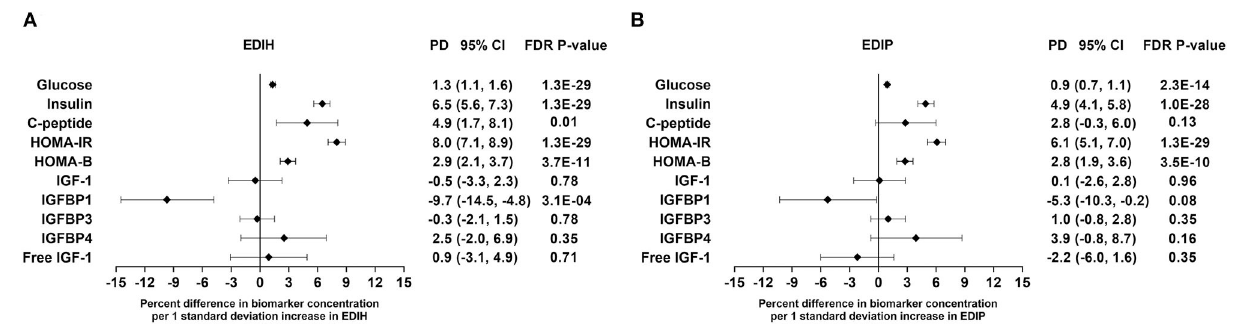
FIGURE 2 | Percentage difference (PD—beta coefficients) (95% confidence intervals) in insulin response/IGF-signaling biomarker per 1 standard deviation increment in EDIH (A) and EDIP (B) in the Women’s Health Initiative. Biomarkers were log-transformed, using natural logs. Values were obtained via multivariable-adjusted linear regression models adjusted for the following variables: total energy intake, BMI-continuous, age, total recreational physical activity, pack years of smoking; number of supplements used, fasting status at blood draw, race/ethnic groups, educational levels, regular use of NSAID, statins, unopposed estrogen and/or estrogen plus progesterone hormones, hormone therapy (HT) study arms. The sample sizes for each biomarker were as follows: glucose, 21,669; insulin, 23,756; C-peptide, 943; HOMA-IR, 19,865; HOMA-B, 19,865; insulin-like growth factor (IGF)-1, 3,126; IGF-binding protein (BP)-1, 993; IGF-BP3, 2,349; IGF-BP4, 354; free IGF-1,